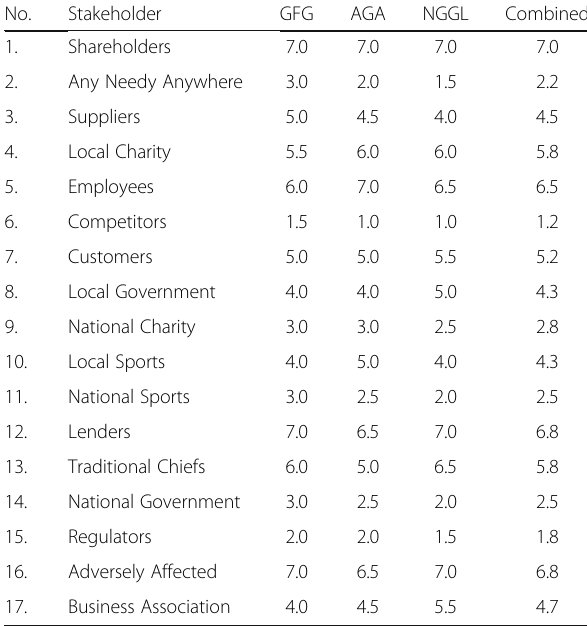
Table 4 Mean scores of mining companies ’ moral obligation